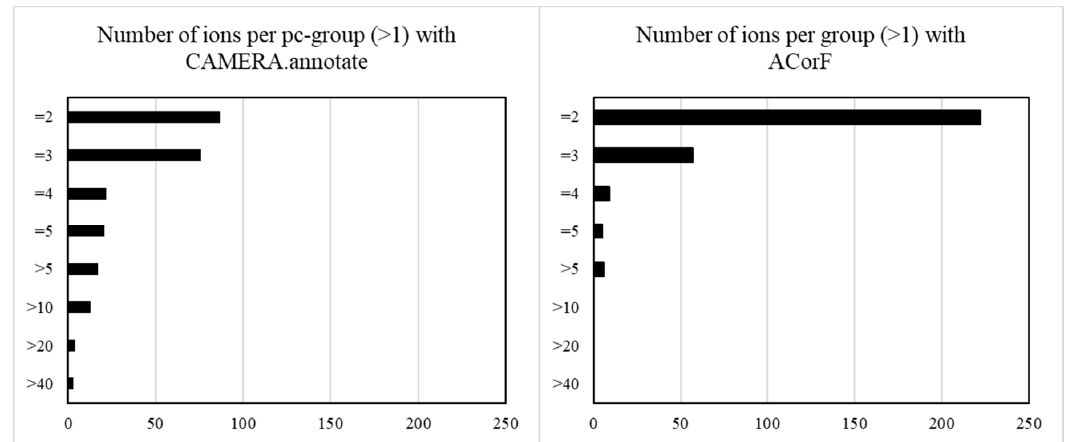
Figure 3. Bar diagram presenting the number of groups (x-axis) by the group size (y-axis: number of ions per group).